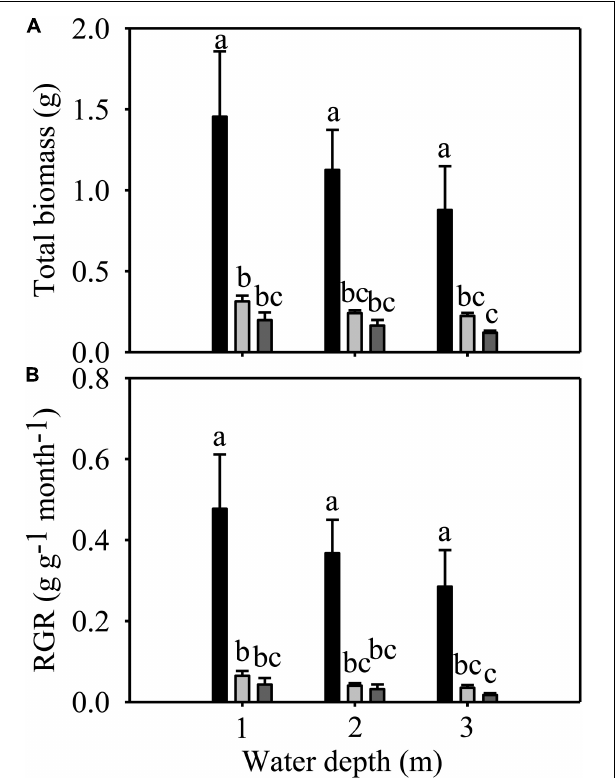
FIGURE 3 | Changes in the total biomass (A) and RGR (B) of three macrophytes. The data are presented as the mean ± 1SE ( n = 7). Means with different small letters are significantly different at P < 0.05 among different